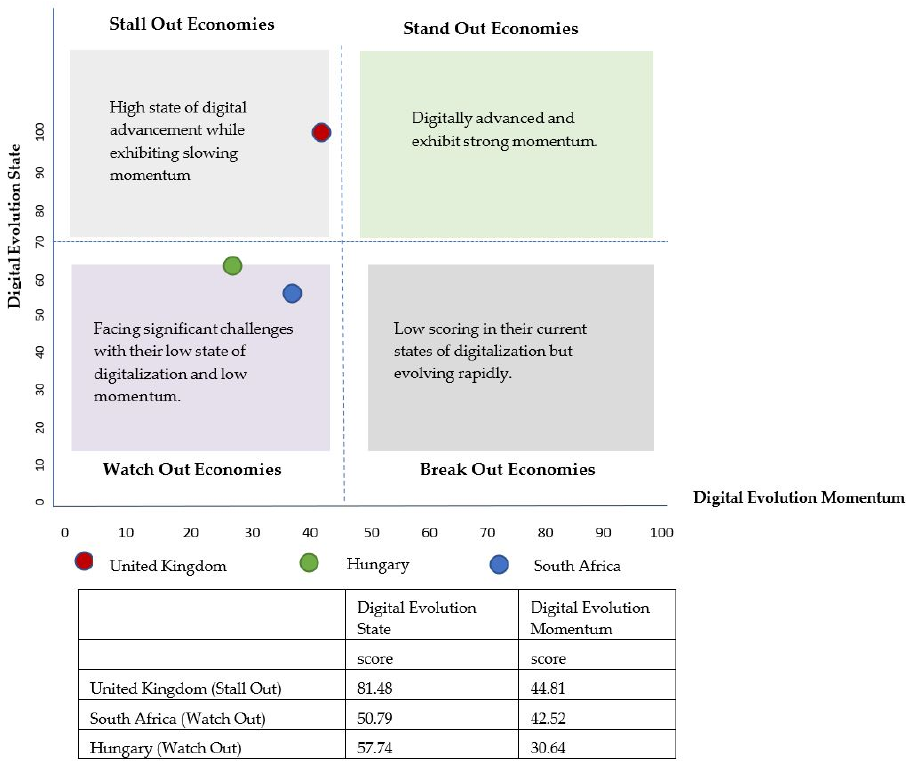
Figure 3. The Digital Intelligence Index by country—United Kingdom, South Africa, Hungary ‐ adapted from Bhaskar, Chaturvedi, Filipovic and Brewer [1].